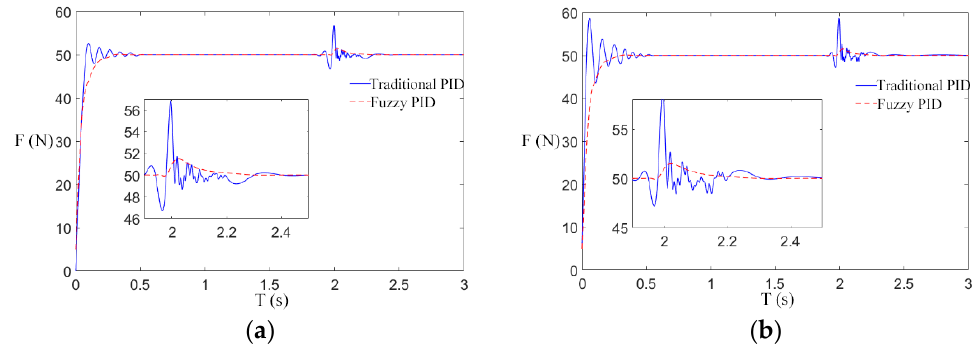
Figure 17. The influence of step when the reference tension is 50 N. ( a ) Situation 1; ( b ) Situation 2.